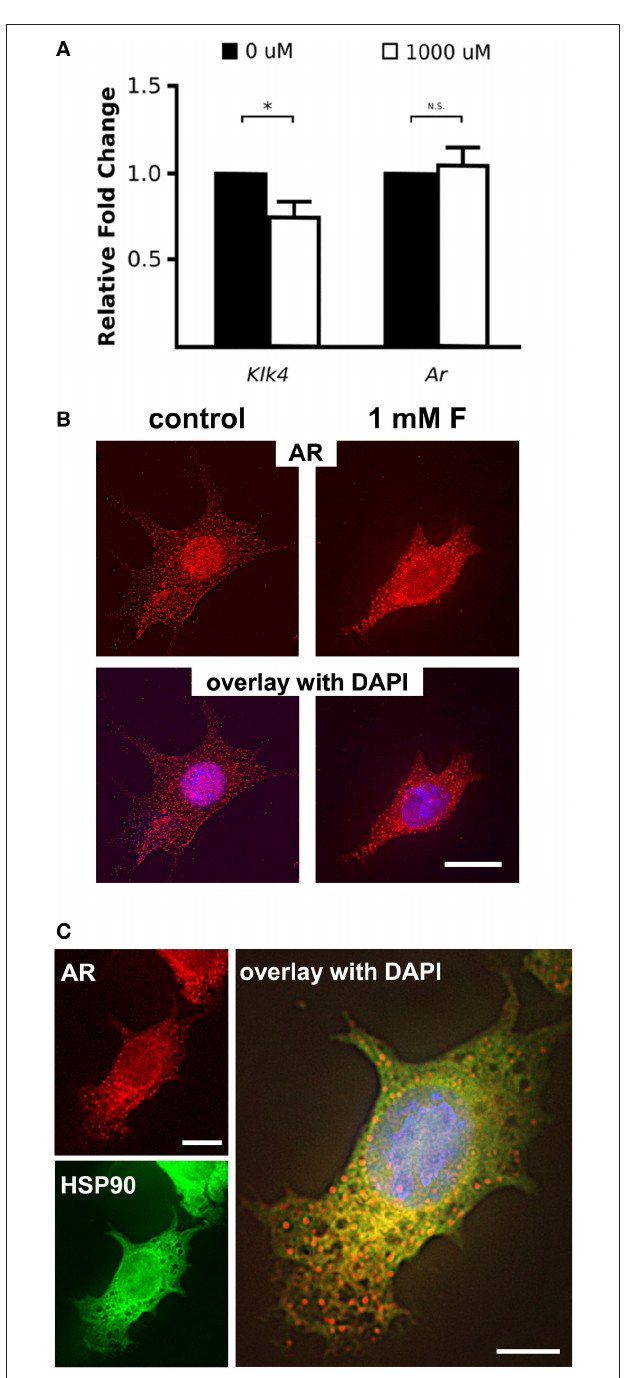
FIGURE 3 | Fluoride reduces Klk4 expression without altering Ar expression. (A) Relative fold change of Klk4 and Ar from ALCs exposed to 0 or 1,000 µ M fluoride showed significant down regulation of Klk4 but not Ar . Expression of target genes were normalized to the expression of Mrpl19 . * p < 0.05. (B) Immunofluorescent staining of AR (red) in ALC showed a relative reduction in AR nuclear translocation in cells exposed to 1mM fluoride. Scale bar 25 µ m. (C) Immunofluorescent staining of AR (in red) and HSP90 (in green) in ALC showed that when AR translocation is blocked by 1mM fluoride, AR and HSP90 are primarily co-localized in the cytoplasm (in yellow). DAPI (in blue), Scale bar 25 µ